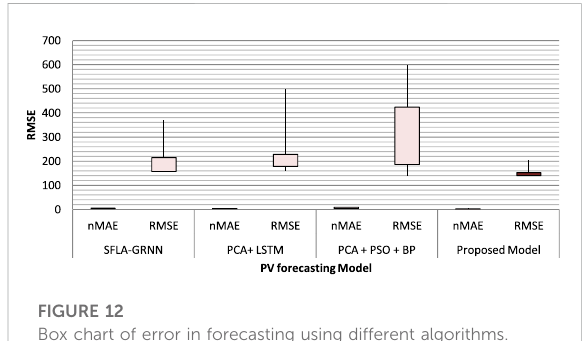
FIGURE 12 Box chart of error in forecasting using different algorithms.